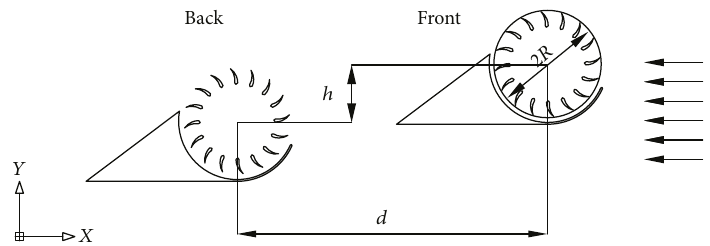
Figure 8: De fi nition of height between the front and rear wings of the tandem fan wing.